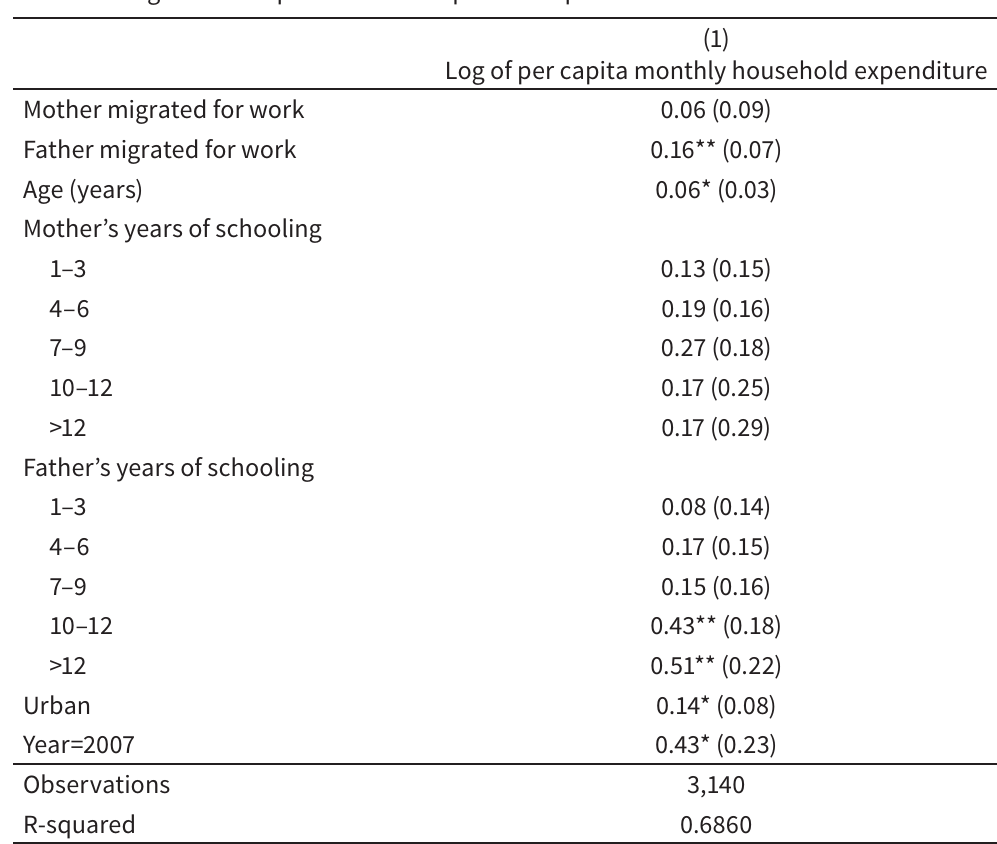
Migration’s impact on consumption as a possible